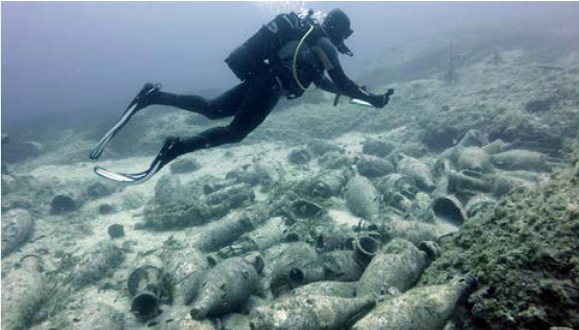
Figure 4. Optical acquisition tasks performed in the underwater archaeological site of Cala Minnola